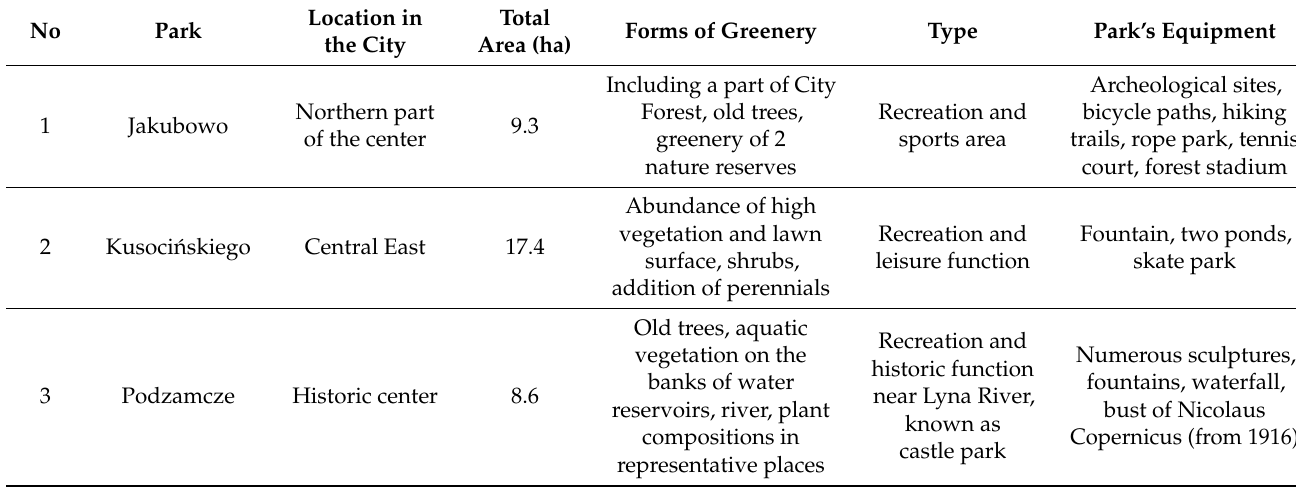
Figure 1. Location of Poland, region of Warmia and Mazury, city of Olsztyn, and the selected parks. Table 1. Basic characteristics of the examined